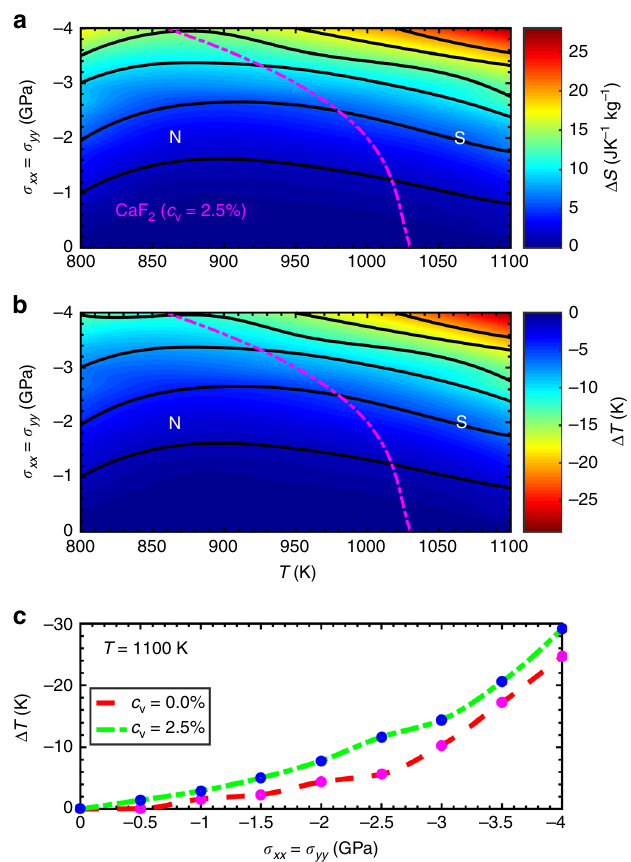
Fig. 2 Effects of vacancies on the mechanocaloric performance of type-II superionic thin fi lms. Isothermal entropy a and adiabatic temperature b shifts calculated in defective CaF 2 ( c v = 2.5%) as a function of temperature and applied biaxial tensile stress. N and S denote normal and superionic states and the magenta dashed line depicts the boundary between them. c Comparison of the adiabatic temperature shifts calculated in perfect and defective CaF 2 thin fi lms as a function of biaxial stress at a fi xed temperature of 1100 K. Lines in c are guides to the performance of FIC should be enhanced. We have found, however, that this is not actually the case in archetypal FIC CaF 2 (see Supplementary Figs. 1 and 2).